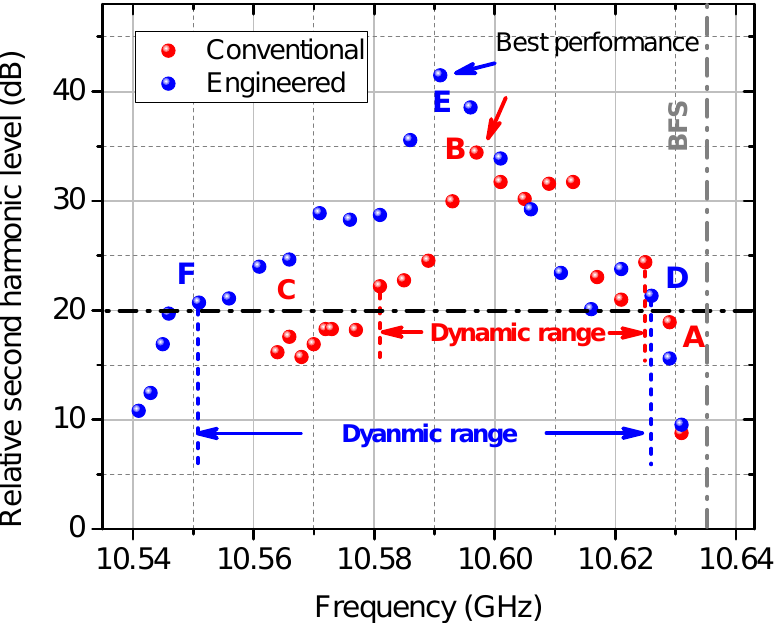
Figure 12. Relative second order harmonic level as a function of the interrogation frequency. A-F are the interrogation frequencies in